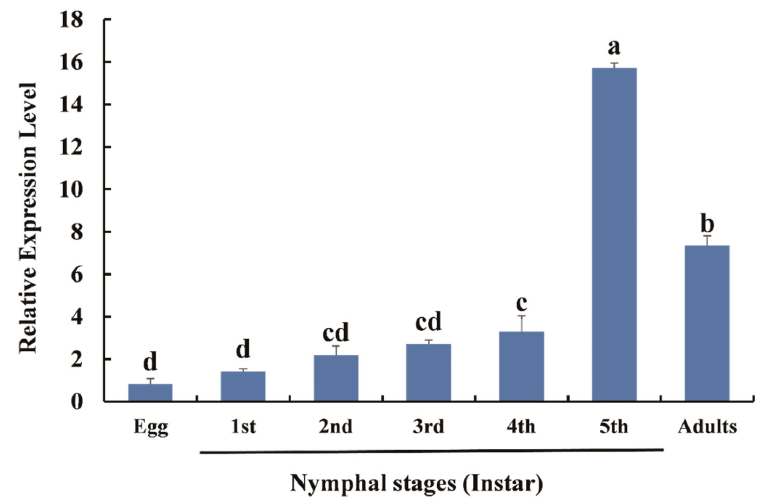
Figure 4. Expression patterns of DcTPS at different developmental stages of D. citri . Relative expression levels of DcTPS were analyzed using RT-qPCR and calculated with the 2 - ΔΔ Ct method. SPSS 26.0 software was used for statistical analysis. Bars with difference letters are significantly different according to Student–Newman–Keuls (S-N-K) test ( p < 0.05).